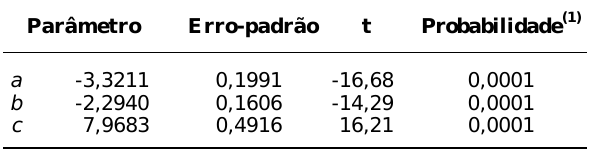
Quadro 2. Estimadores dos parâmetros da regressão linearizada, para resistência a penetração do solo (RP = MPa), em função do conteúdo volumétrico da água ( qqqqq = m 3 m -3 ) e densidade (Ds = Mg m -3 ) do solo: ln RP = ln a + b ln qqqqq + c lnDs